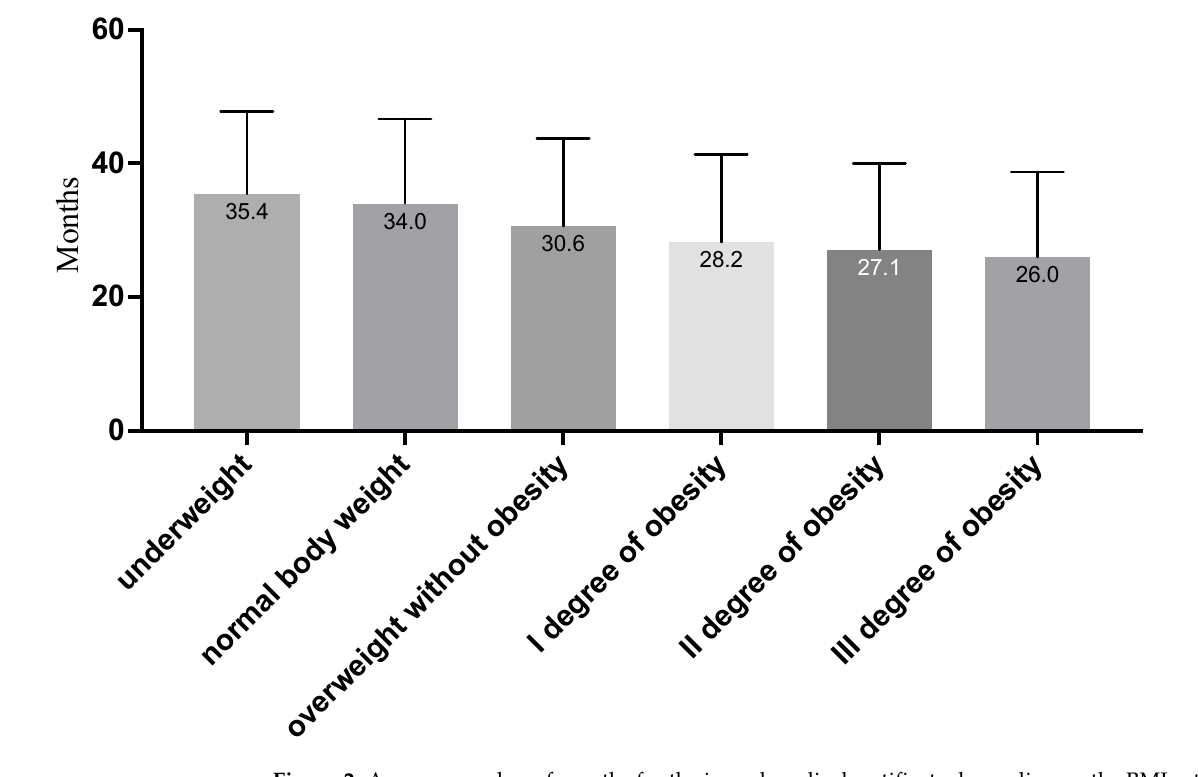
Figure 2. Average number of months for the issued medical certificate depending on the BMI category (in the figure, all groups are statistically significantly different, at least at the p < 0.05 level; due to the number of groups compared, results for differences are not shown in the figure).